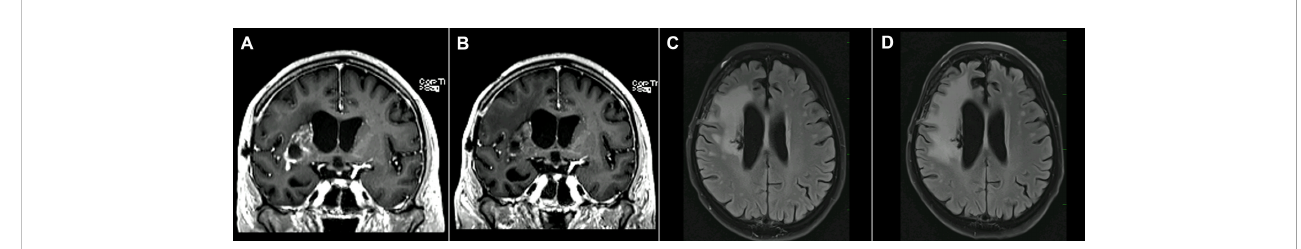
FIGURE 3 59-year-old female. (A) April 2019, 3 Tesla scanner “ bevacizumab-like ” TTFields effect: T1-weighted postcontrast gradient echo postoperative image with enhancing residual GBM in the region of the basal ganglia on the right side. (B) July 2019, 3 Tesla scanner: T1-weighted postcontrast gradient echo image (identical scanner, sequence parameters, type and dose of the contrast agent [Gadovist 6 ml]) shows a decrease in postcontrast enhancement. However, the neurological status of the patient progressed. (C) April 2019, 3 Tesla scanner, FLAIR image and (D) July 2019, 3 Tesla FLAIR image show edema progression at the time when enhancement